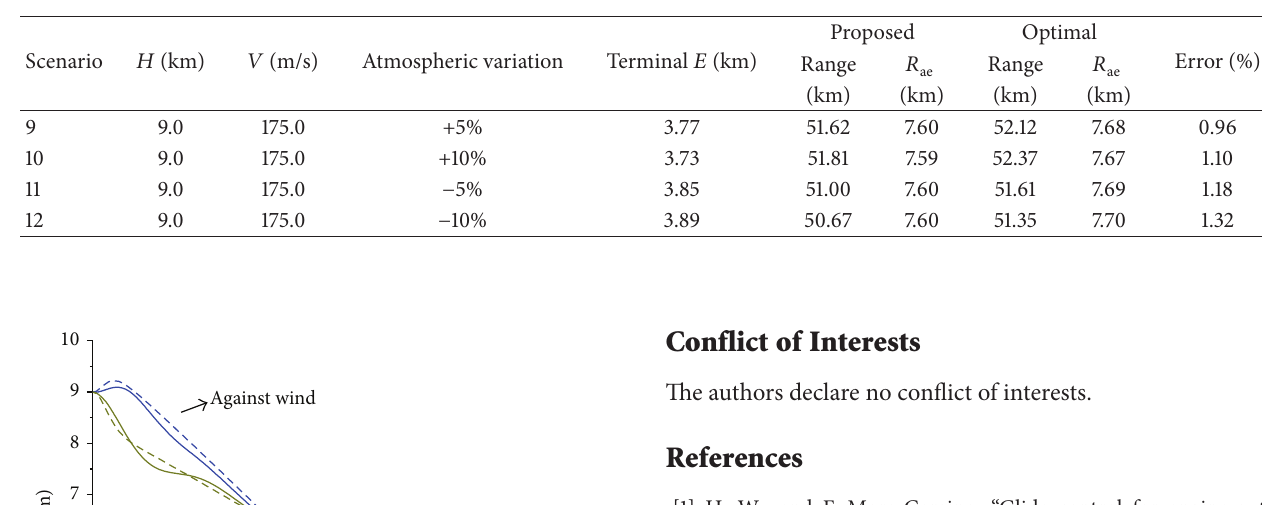
Table 6: Simulation results with atmospheric variations.